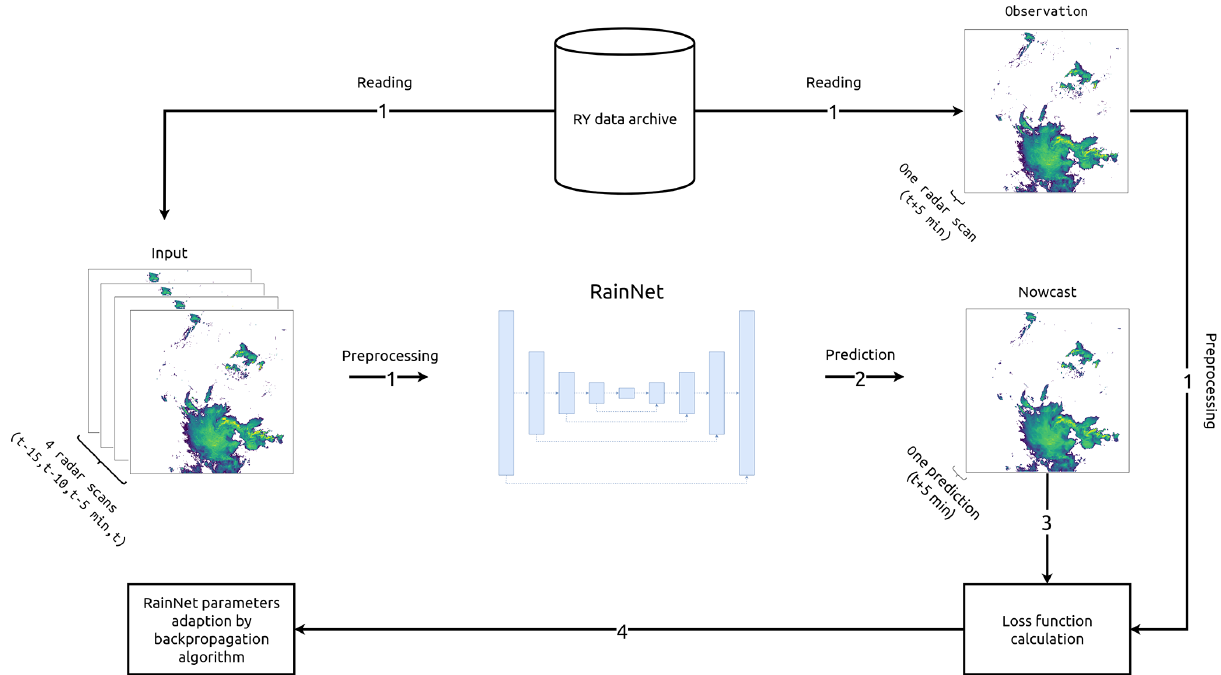
Figure 2. Illustration of one iteration step of the RainNet parameters optimization